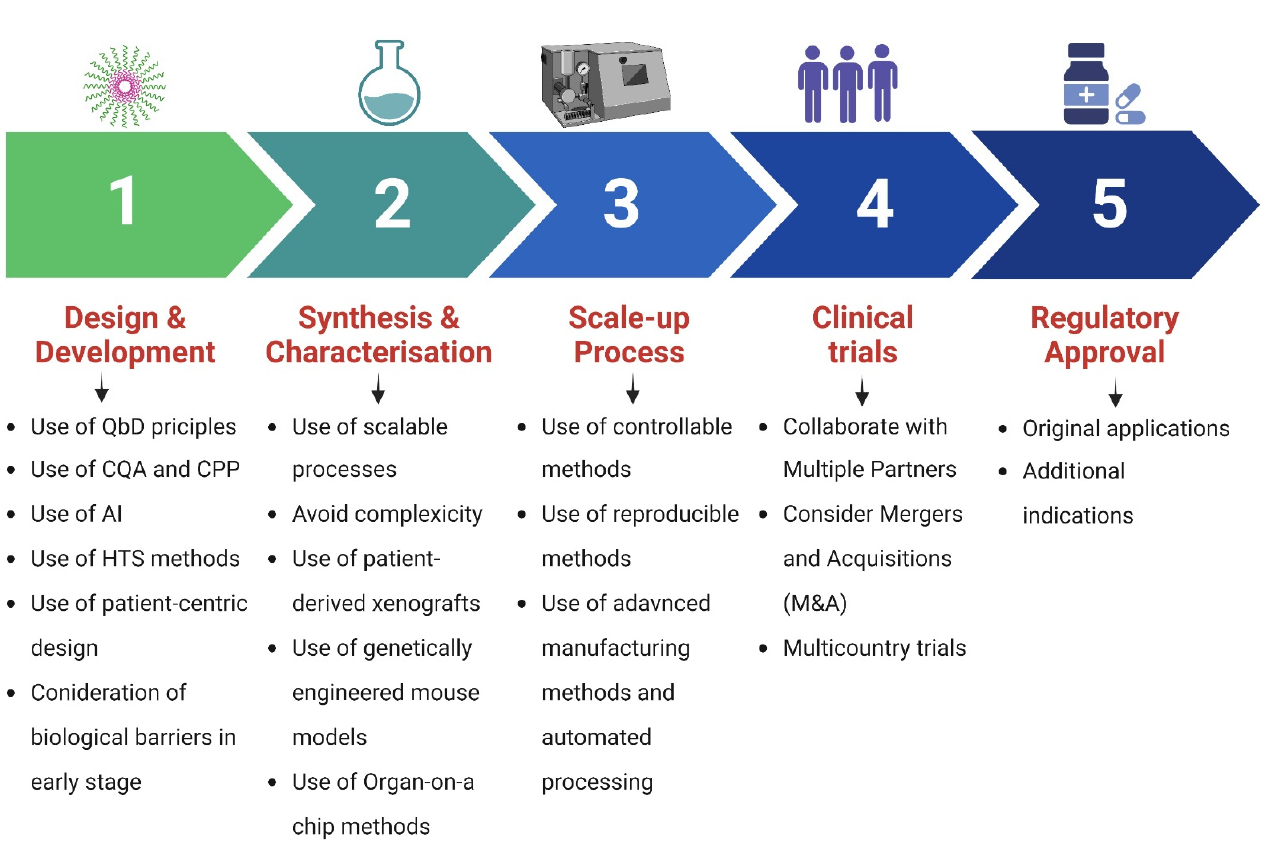
Figure 9. Steps and principles involved in the successful clinical translation of polymeric micelles. QbD, Quality by Design; CQAs, critical quality attributes; CPPs, critical process parameters; AI, ar- tificial intelligence; HTS, high-throughput screening.